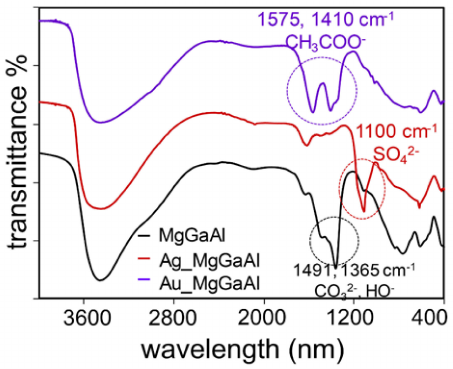
Figure 2. FT-IR spectra of MgGaAl, Ag_MgGaAl and Au_MgGaAl.